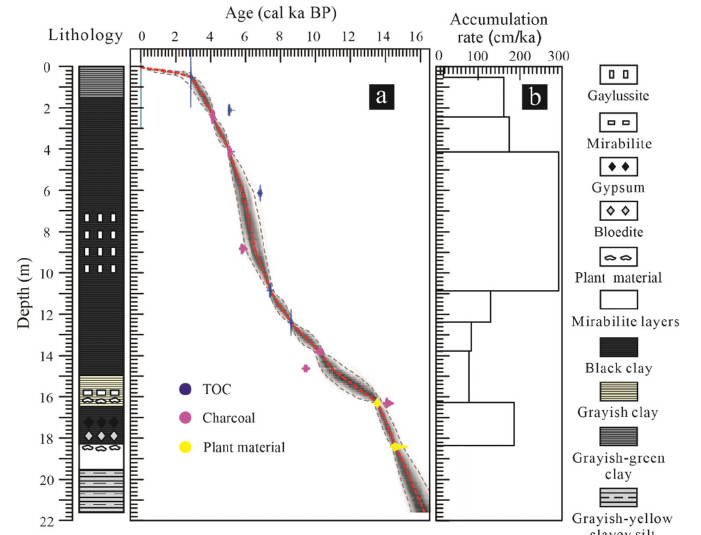
Figure 2. Lithology and geochronology of core AGL ‐ 2010 [21]. ( a ) Bayesian age ‐ depth model [20]. ( b ) Sedimentation ‐ rate histogram. Sedimentation rates are calculated between AMS 14 C ages that fall on the red dashed line.